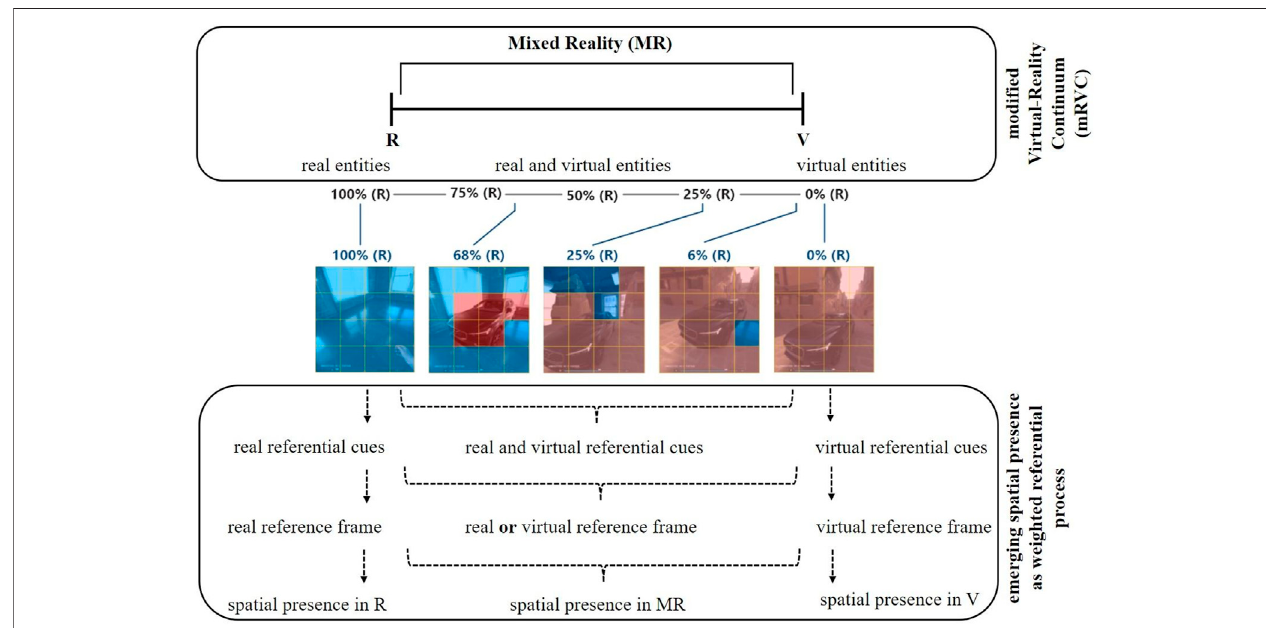
FIGURE2| Illustratesthedeterminationofreality(blue)andvirtuality(red)portionsonthemRVCbeingusefulforexperimentalsetupstestingassumptionsaboutthe spatial presence in MR.